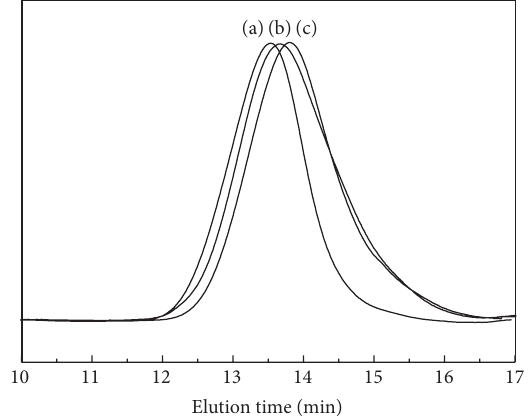
Figure 3: Gel permeation chromatography traces of the obtained P(LA- co -BMD). (a) P(LA 98 - co -BMD 2 ), (b) P(LA 95 - co -BMD 5 ), and (c) P(LA 92 - co -BMD 8 ).